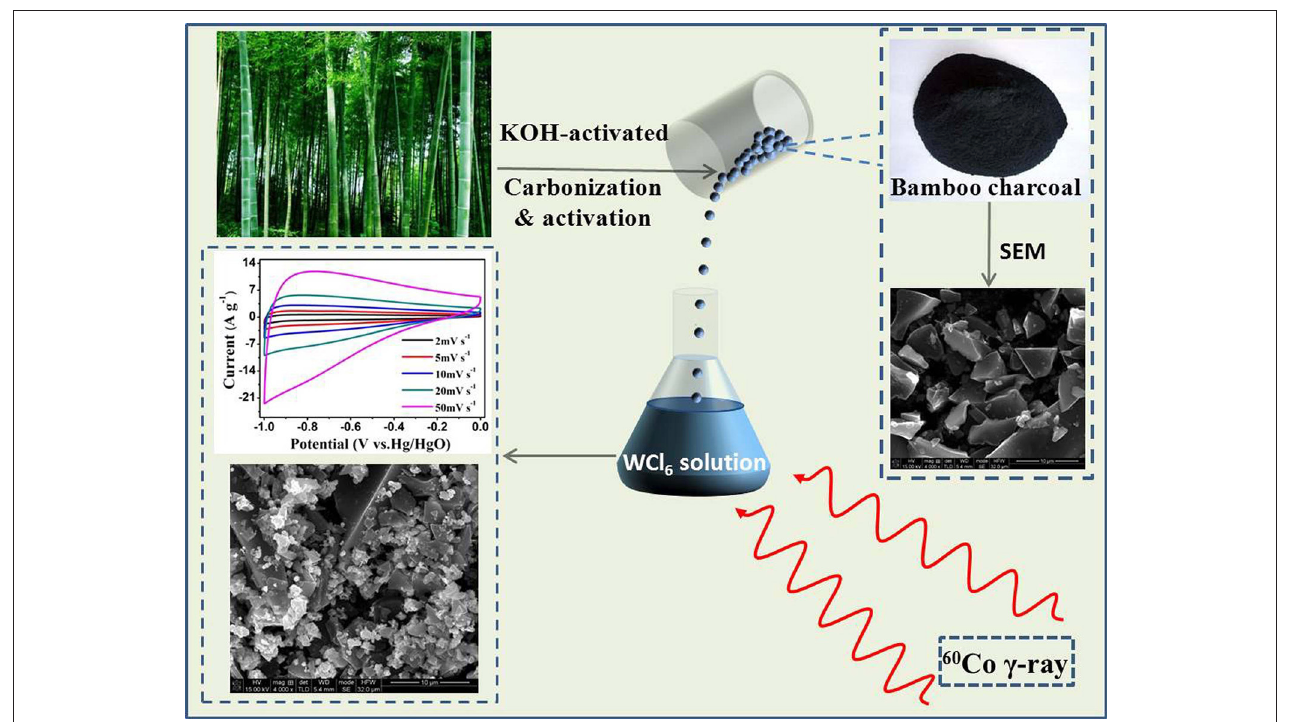
FIGURE 1 | Schematic diagram for the synthesis of WO 3 · 2H 2 O/BC hybrids and their supercapacitor performance.